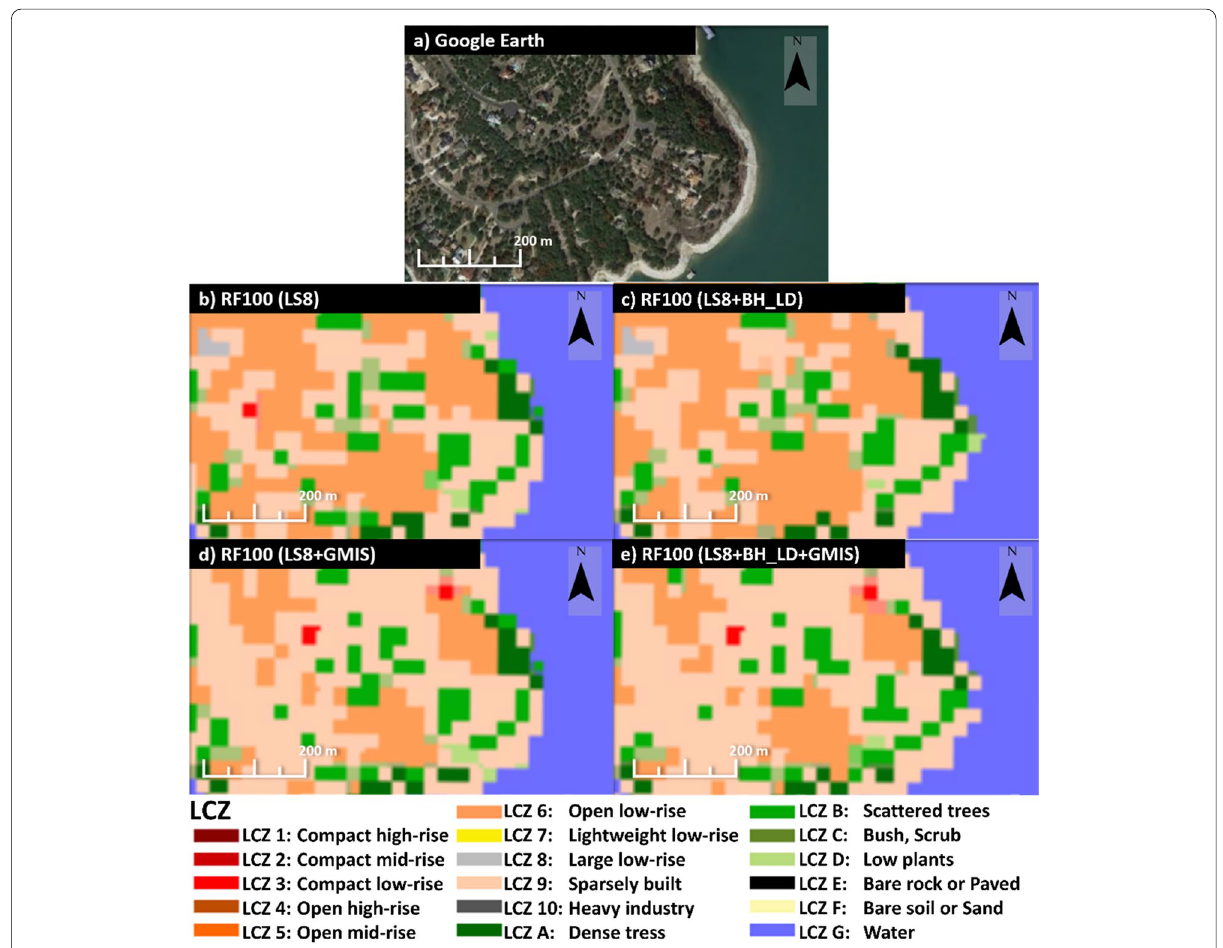
Fig. 9 The a Google Earth image, b RF100 with LS8 as input, c RF100 with LS8 and BH_LD as input, and d RF100 with LS8, BH_LD, and GMIS as input at the Northlake